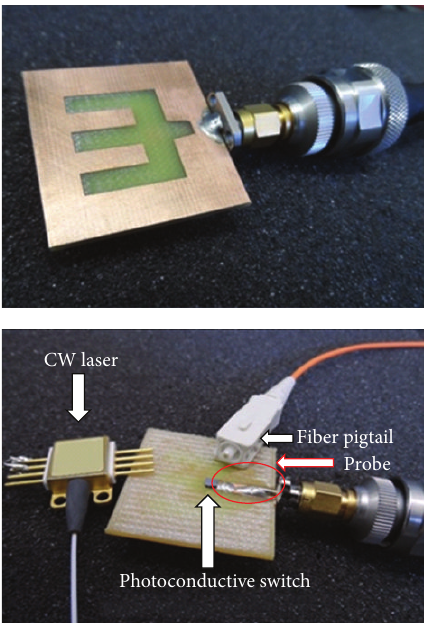
Figure 2: Fabricated